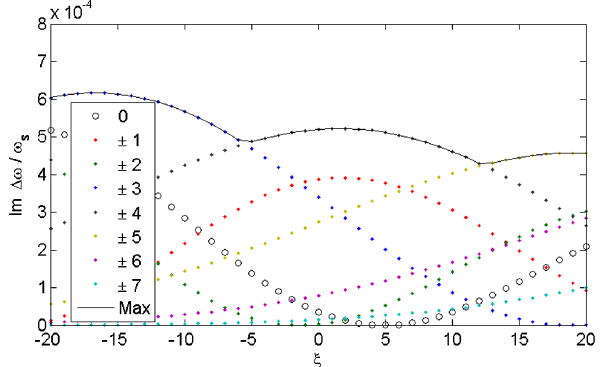
FIG. 5. The chromaticity has little effect on the maximum growth rate. Analytic solution for a weak head-tail limit Eq. (20), equispaced beam of 3564 bunches, 10 10 ppb, no